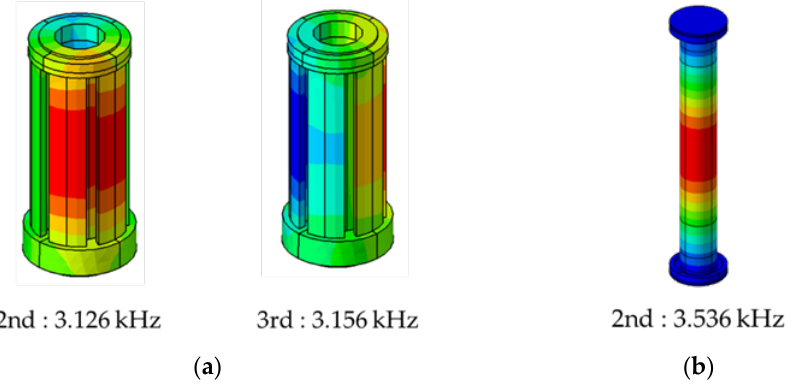
Figure 10. Acoustic mode for the standard model: ( a ) outside rotor and ( b ) inside rotor.